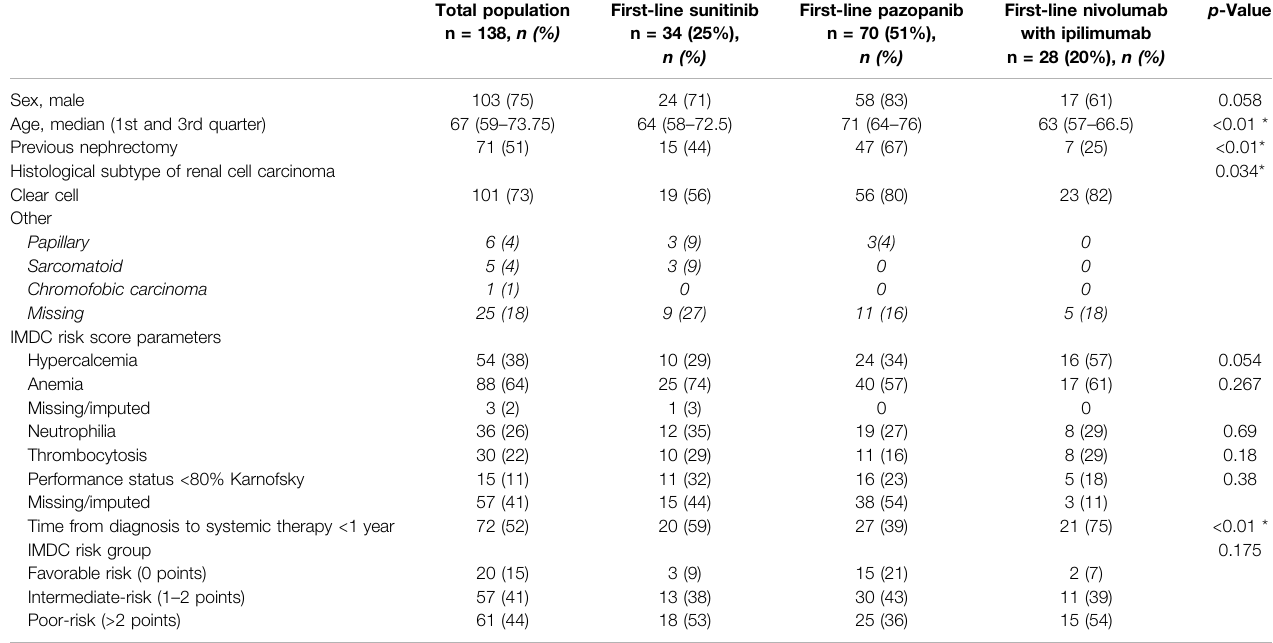
TABLE 1 | Patient characteristics of complete study population and fi rst-line sunitinib, pazopanib, and nivolumab with ipilimumab.